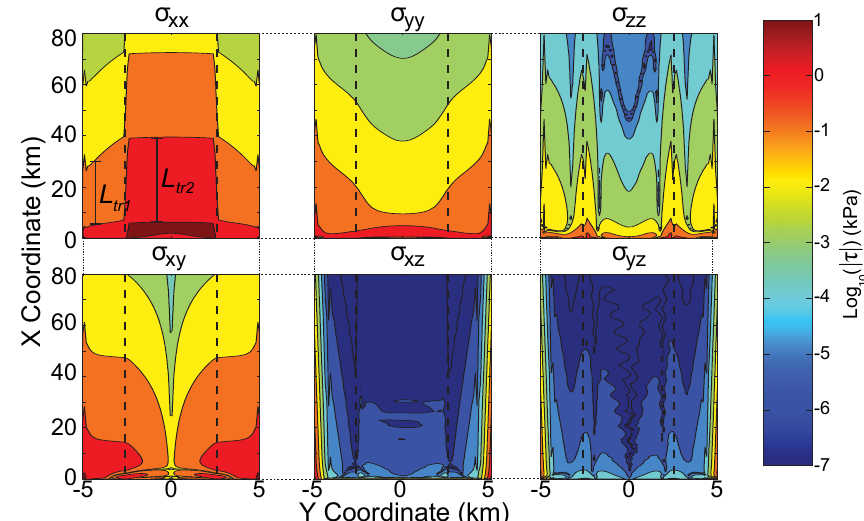
Figure 8. Representative distribution of stress for a model with the same geometry as Fig. 6, but with ice margins that are 25% of the ice stream width. These margins are a factor of 10 more compliant than in the center of the ice